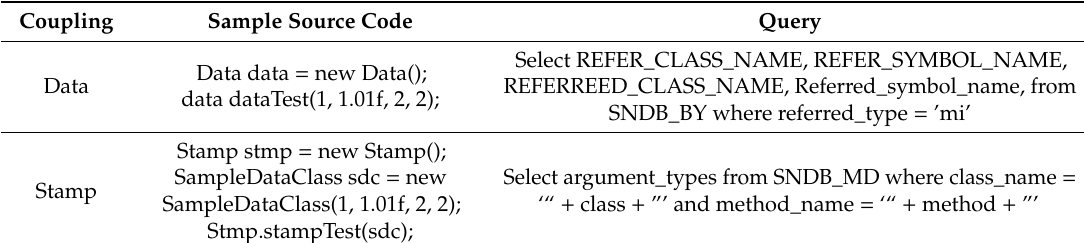
Table 3. Example of code and queries for extracting data and stamp